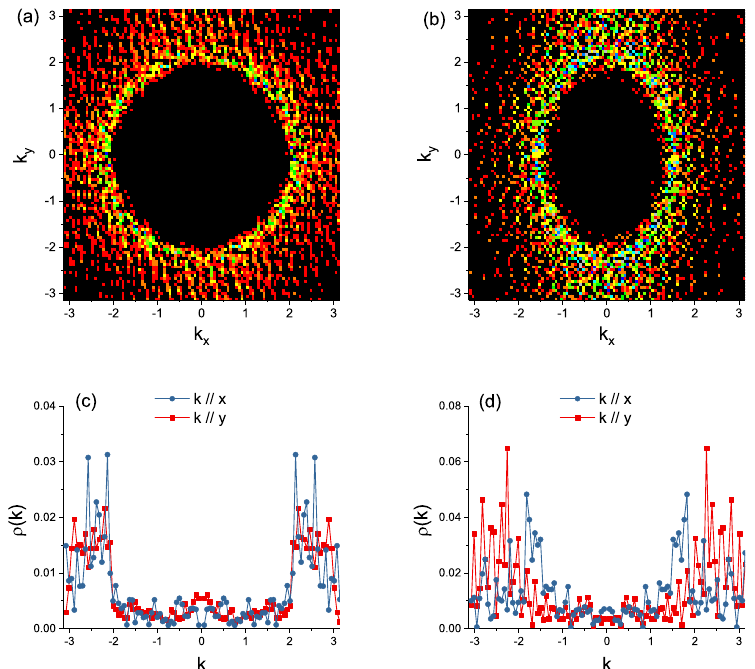
Figure 6: The Fourier transform ρ ( k ) of the LDOS for (a) a symmetric model with = t (cid:54) = t t , and (b) a nematic model with t . There are 20 random impurities in x y x y the 100 × 100 system. The contour of the ρ ( k ) peaks follow closely the geometry of the Fermi surface, thus indicates the model symmetry and the presence or absence of the nematic order. (c) The peak locations of ρ ( k ) in (a) along the high symmetry di- rections ˆ x and ˆ y overlap, while (d) the peaks of ρ ( k ) in (b) along the high symmetry directions ˆ x and ˆ y clearly sit at different values of k